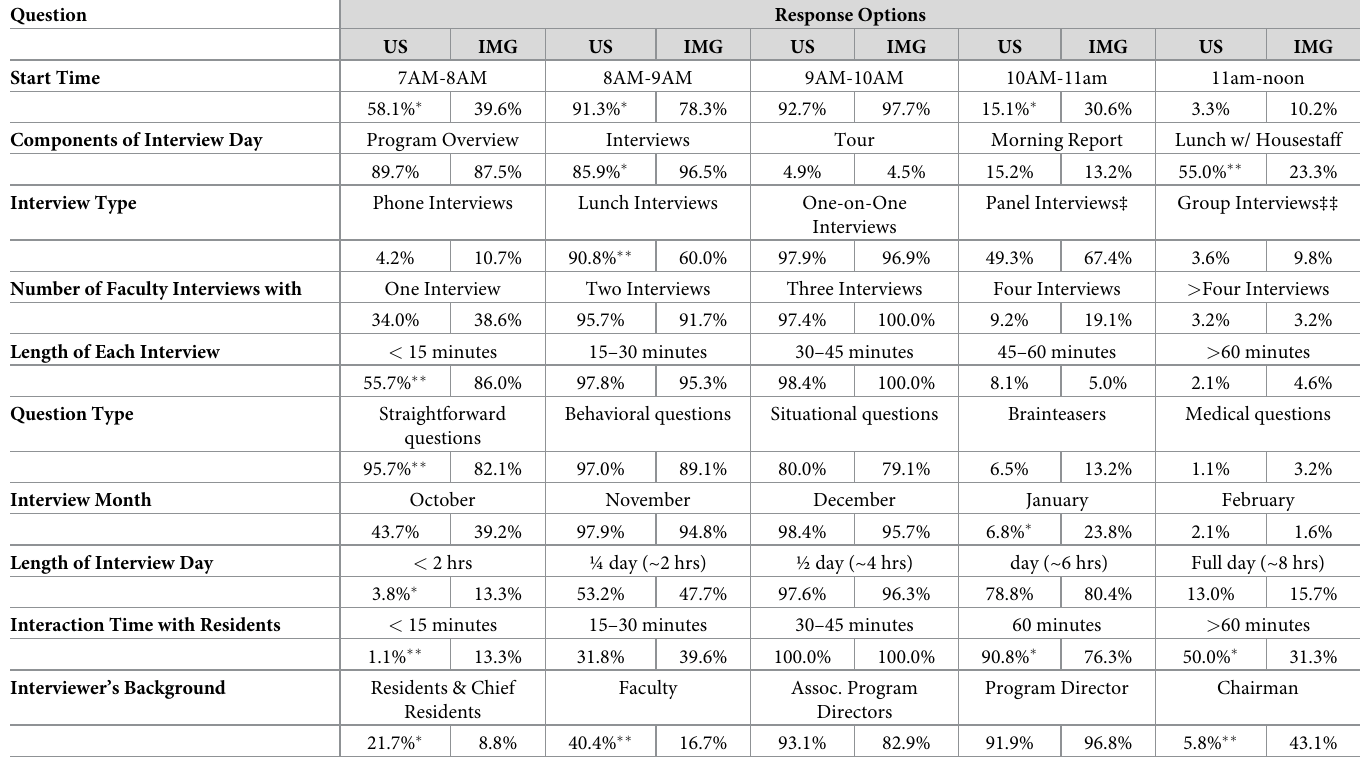
Table 2. Preference for US vs IMG